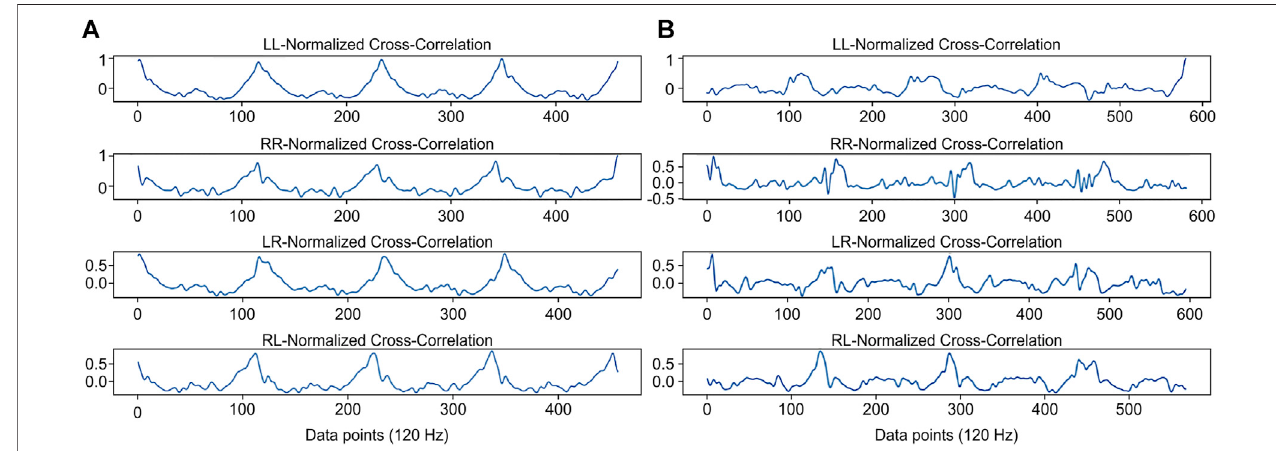
FIGURE5| Thenormalizedcross-correlationcoef fi cients( NCC )inleft-to-left NCC series(LL),left-to-right NCC series(LR),right-to-right NCC series(RR),andright- to-left NCC series (RL) for (A) non-fallers and (B) recurrent